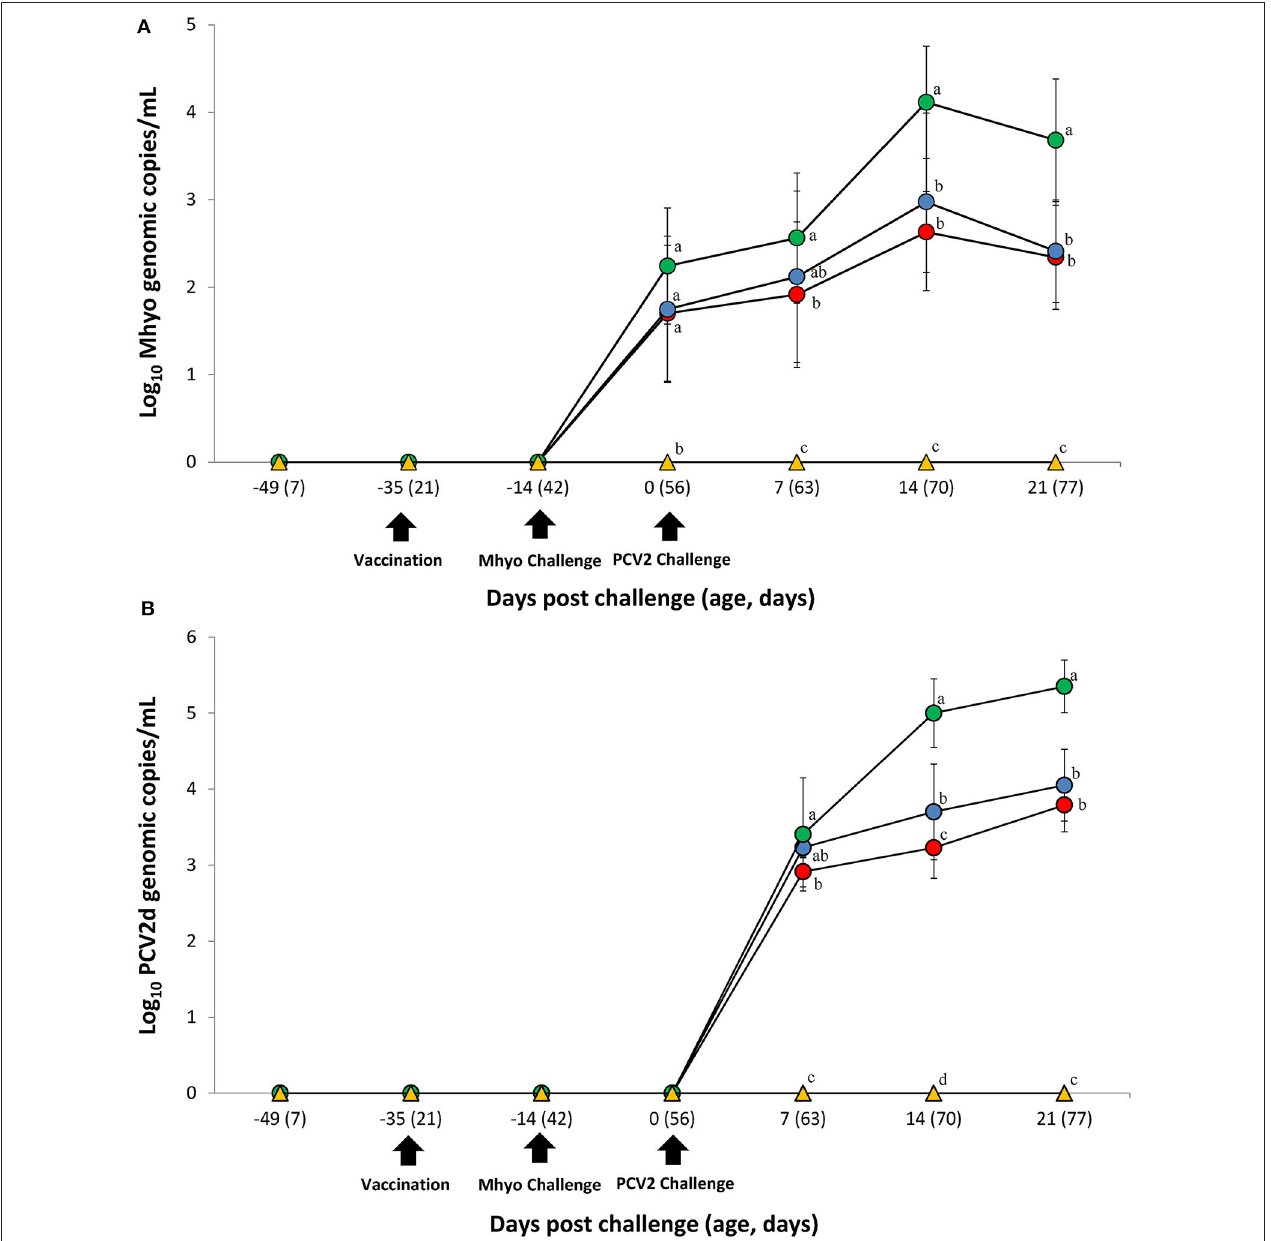
FIGURE 2 | Genomic quantification. (A) Mean values of the genomic copy number of Mycoplasma hyopneumoniae (Mhyo) DNA in nasal swabs. (B) Mean values of the genomic copy number of porcine circoviorus type 2d (PCV2d) DNA in serum in the different groups: VacA/Ch (•), VacB/Ch (•), UnVac/Ch (•), and UnVac/UnCh ( N ). Variation is expressed as the standard deviation. Different letters within a sampling point mean statistically significant differences ( P < 0.05).